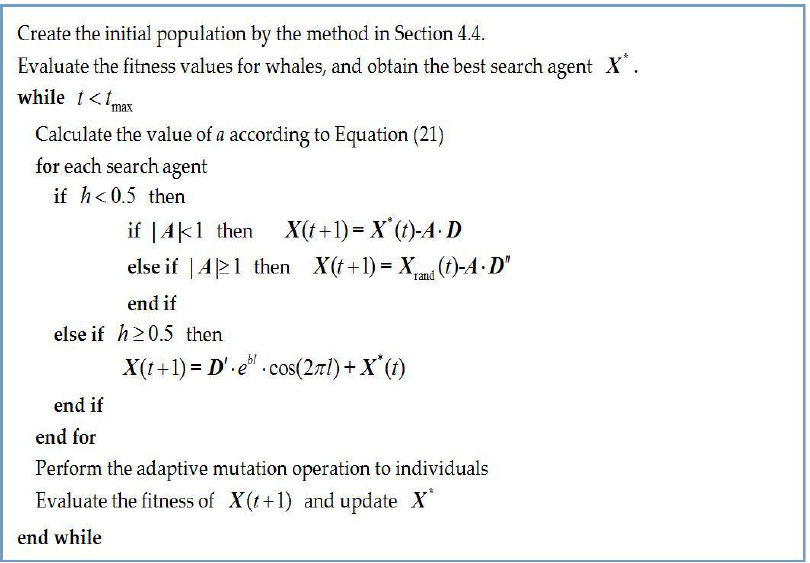
Figure 8. The pseudo code of the improved WOA (IWOA).